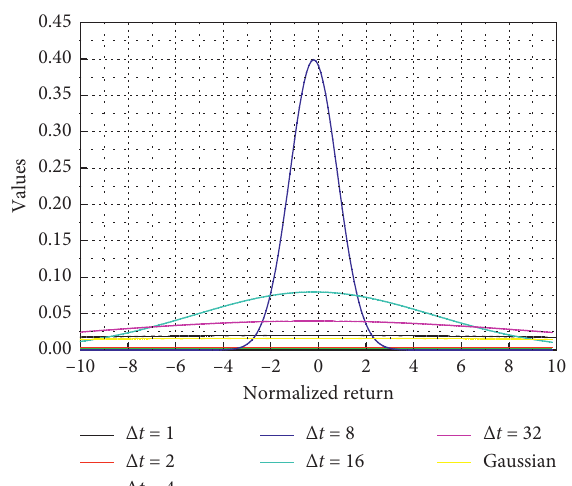
Figure 6: Financial market income distribution.